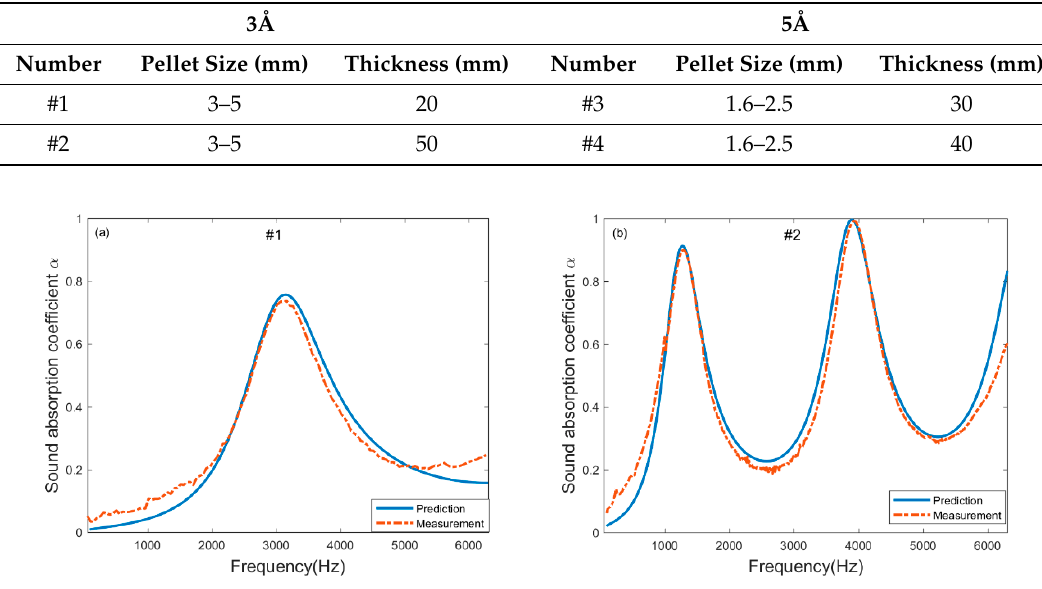
Table 5. Samples of molecular sieve pellets for prediction.